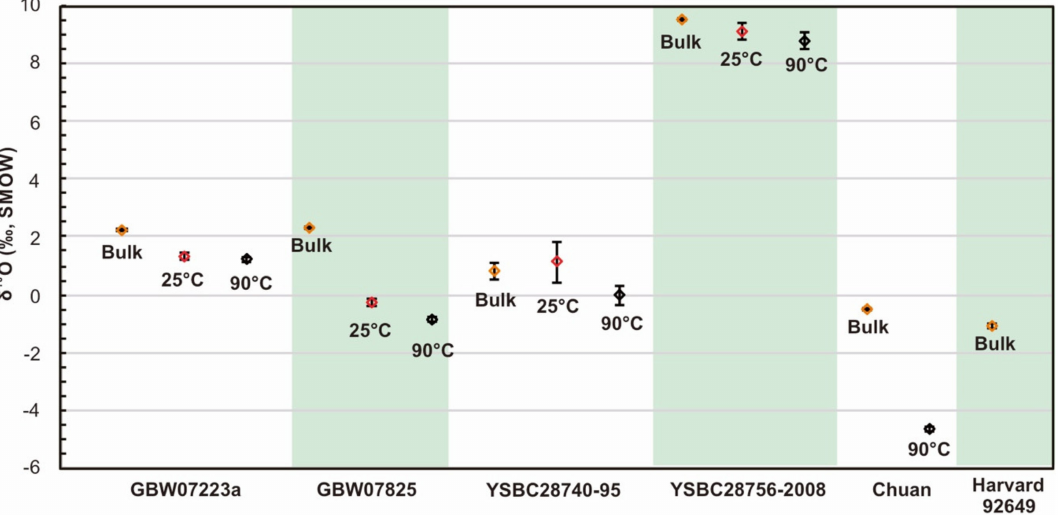
Figure 4. Ratio of bulk rock δ 18 O and corrected δ 18 O Oxides for hematite RMs. The orange rhombi represent the bulk rock δ 18 O. The red rhombi represent the corrected δ 18 O Oxides after HCl dissolution treatment at room temperature (25 ◦ C). The black rhombi represent the δ 18 O Oxides after HCl dissolution treatment at 90 ◦ C. The error bars represent 1 σ